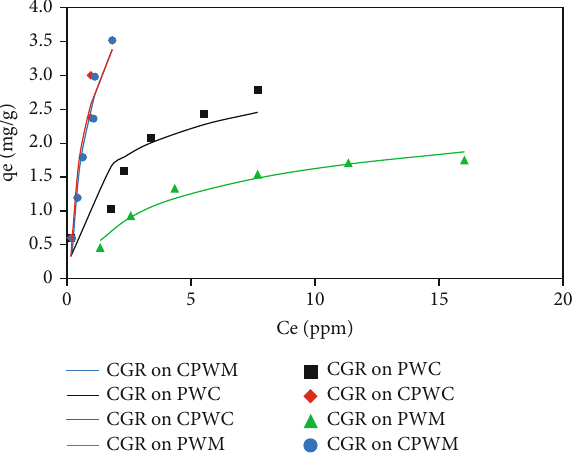
Figure 16: Nonlinear Temkin isothermal